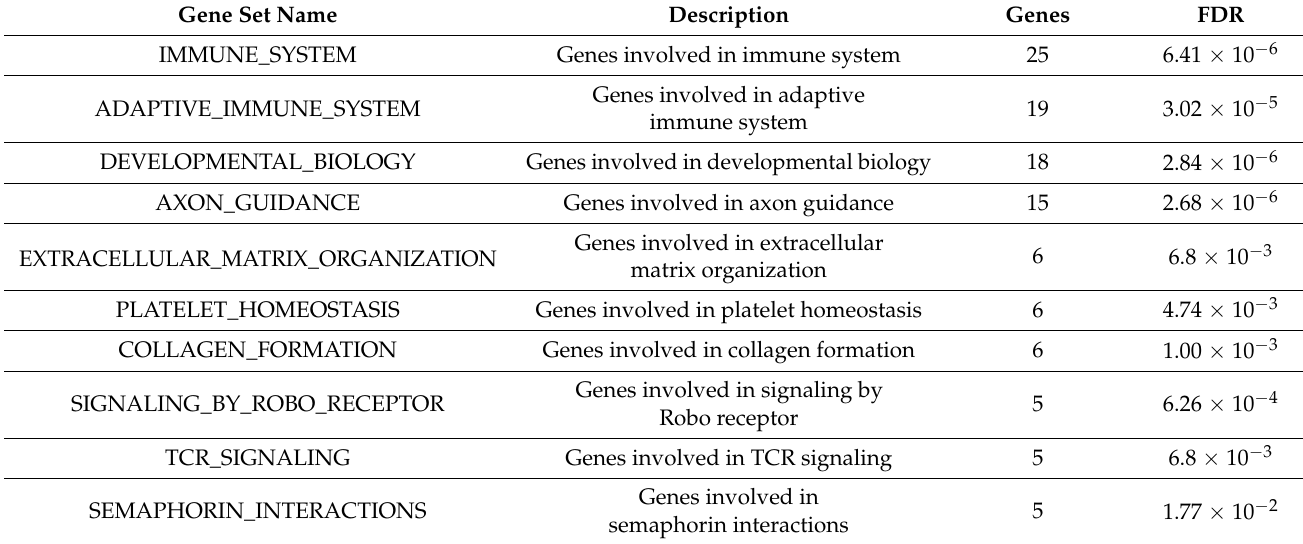
Table 1. Top 10 hits of GSEA. We found 529 differential expressed genes in heart tissue from LGK-974 compared to DMSO-treated animals. Using GSEA we identified classes of genes that are over- represented in our differential expressed gene set. Many genes that were differentially expressed were either associated with immunity or participated in fibrotic processes (e.g., extracellular matrix (ECM) organization and collagen formation). Genesets are derived from the reactome pathways